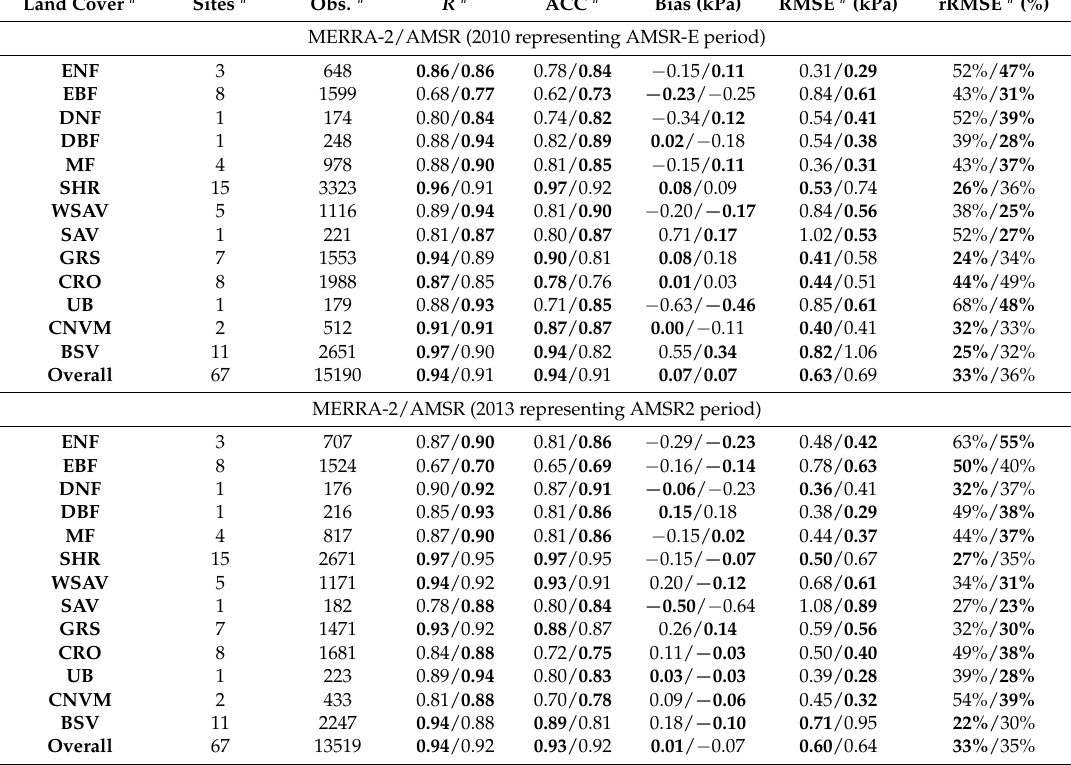
Table 1. Summary of the accuracy of daily afternoon (~1:30 p.m.) Vapor Pressure Deficit (VPD) levels derived from respective the Modern-Era Retrospective analysis for Research and Applications, Version 2 (MERRA-2) and the Advanced Microwave Scanning Radiometer (AMSR) Land Parameter Data Record (LPDR) datasets for 2010 and 2013 in relation to in situ Integrated Surface Global Hourly (ISH) station measurements from 67 global validation sites. The best performance of each metric is highlighted in bold. Land Cover